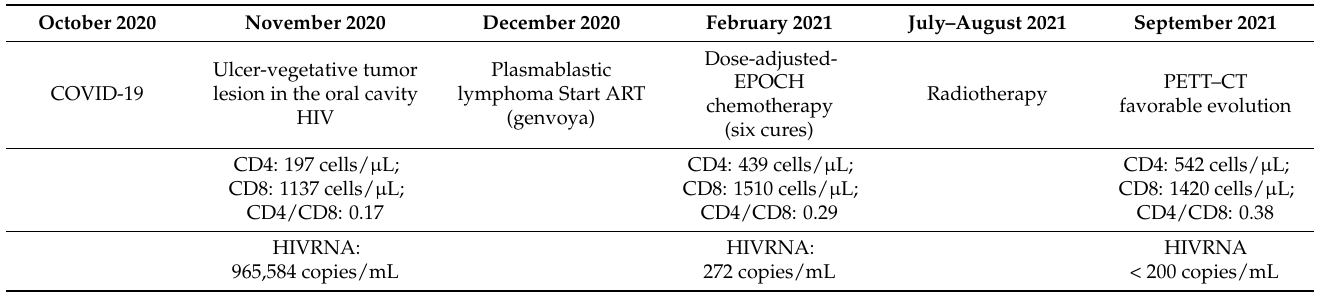
Table 1. Patient’s